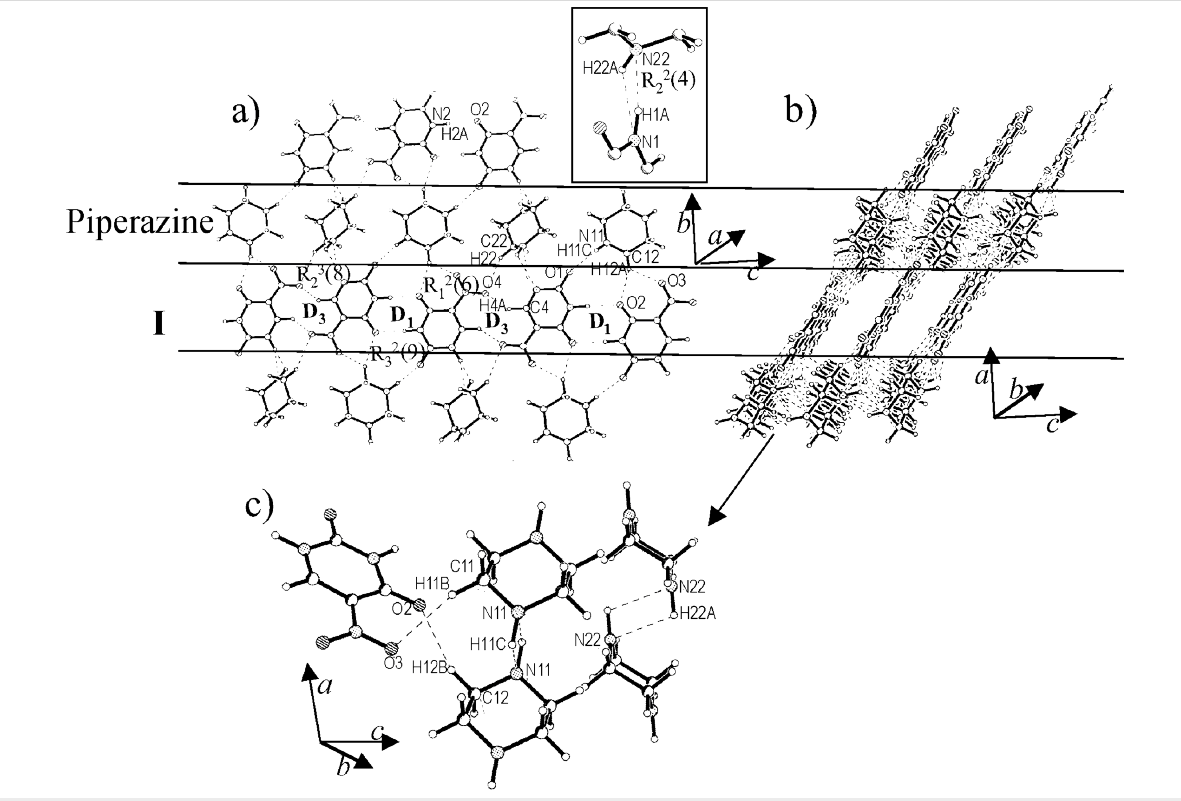
Figure 2: Cocrystal of I and piperazine: (a) A molecular layer showing alternating tapes of I and piperazine. Inset shows a cyclic N-H...O dimer formed between adjacent rows. (b) View along b -axis, showing layered structure and (c) Hydrogen bonds connecting adjacent layers.